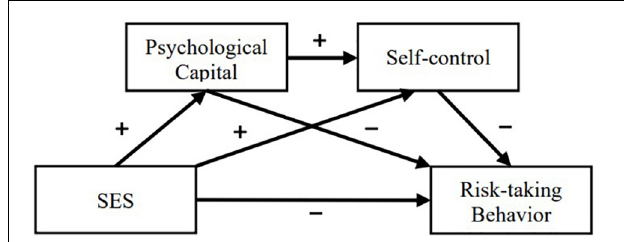
FIGURE 1 | Conceptual